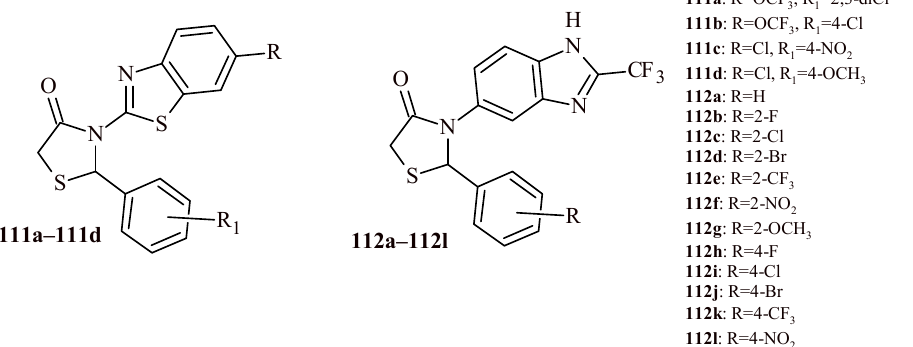
Figure 47. TZD derivatives with antimicrobial potential. their chlorosubstituted analogues ( 111c , 111d ) against L. monocytogenes and P. aeruginosa resistant strain with MIC = 60 µ g/mL [117,118]. The replacement of benzothiazole moiety by the benzimidazole fragment (Com- pounds 112a – 112l ) led to increasing antibacterial activity both for Gram-positive and Gram-negative strains (Figure 48). The most active compound against S. aureus was Derivative 112k with trifluoromethyl substituent (MBC = 0.12 µ M). The compounds with trifluoromethyl and bromo groups ( 112d , 112e and 112j ) were most active against K. pneumoniae (MBC = 0.14 µ M). Whereas Compound 112l showed activity against three Gram-negative strains ( Salmonella thyphimurium , K. pneumonia and E. coli ) with MBC value 0.15 µ M [119].